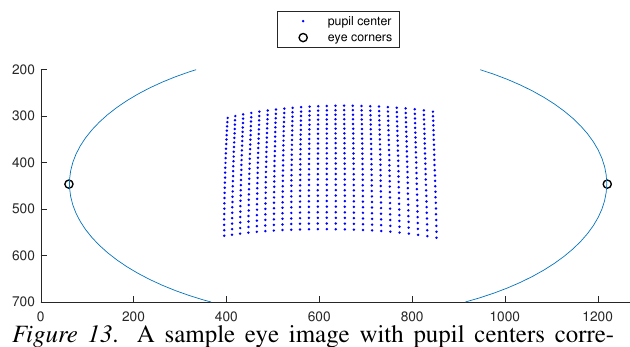
Figure 13 . A sample eye image with pupil centers corre- sponding to 625 target points in the scene image when having a lens